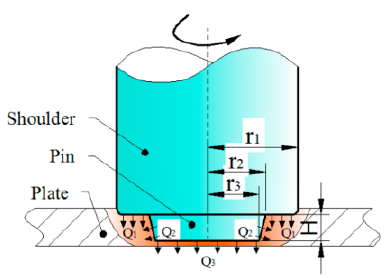
Figure 5. Schematic diagram of heat source distribution of friction tool.